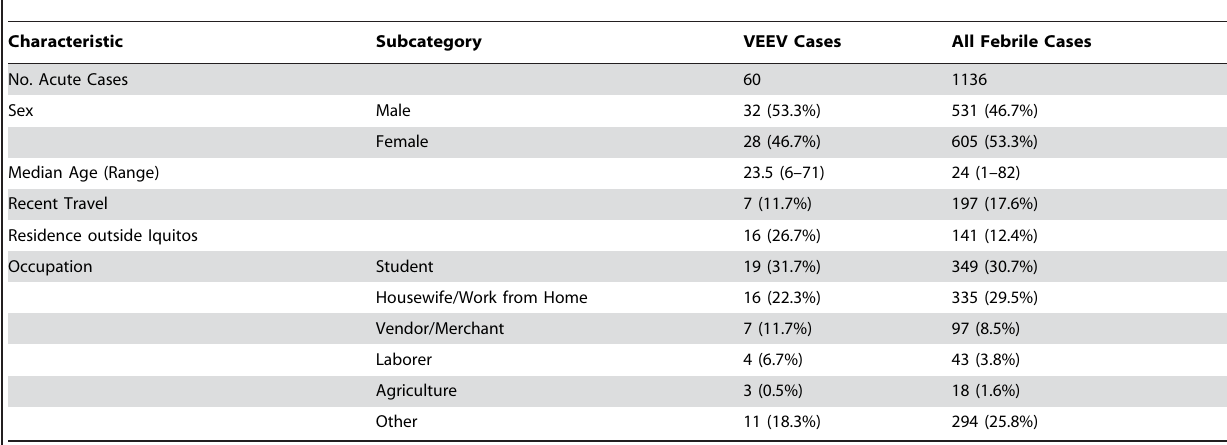
Table 2. Demographic information of VEEV febrile patients and all other febrile patients reporting to public health centers in 2006.